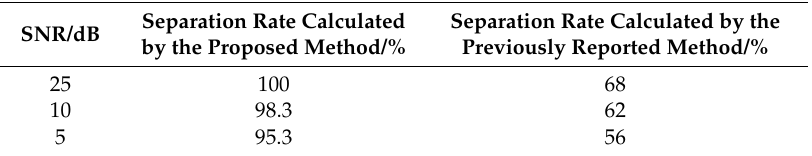
Table 6. The separation results by the proposed method and the published method.